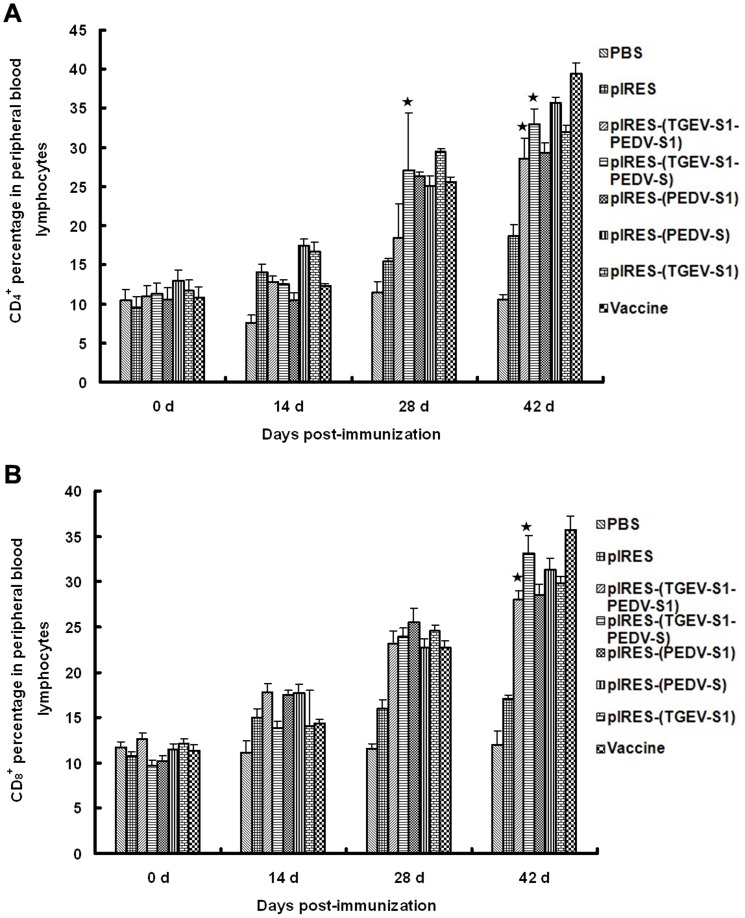
Changes in CD4
+ and CD8
+ T lymphocytes in the peripheral blood of immunized mice.Lymphocytes from the peripheral blood of mice treated with recombinant plasmids were collected and subjected to flow cytometry to assess the numbers of CD4
+ T lymphocytes (A) and CD8
+ T lymphocytes (B). ★: p<0.01 (highly significant), compared with PBS group and pIRES group.